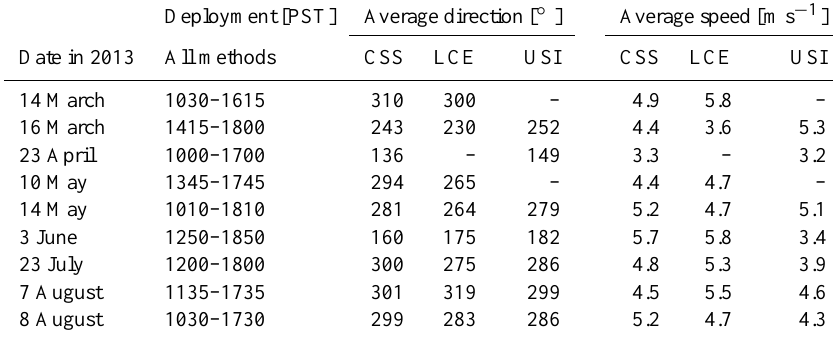
Table 2. Deployment dates and average direction and speed for each cloud motion sensor. USI CMVs are unavailable for 14 March and 10 May due to incorrect cloud heights. LCE results are removed on 23 April due to an insufficient amount of results that passed QC.